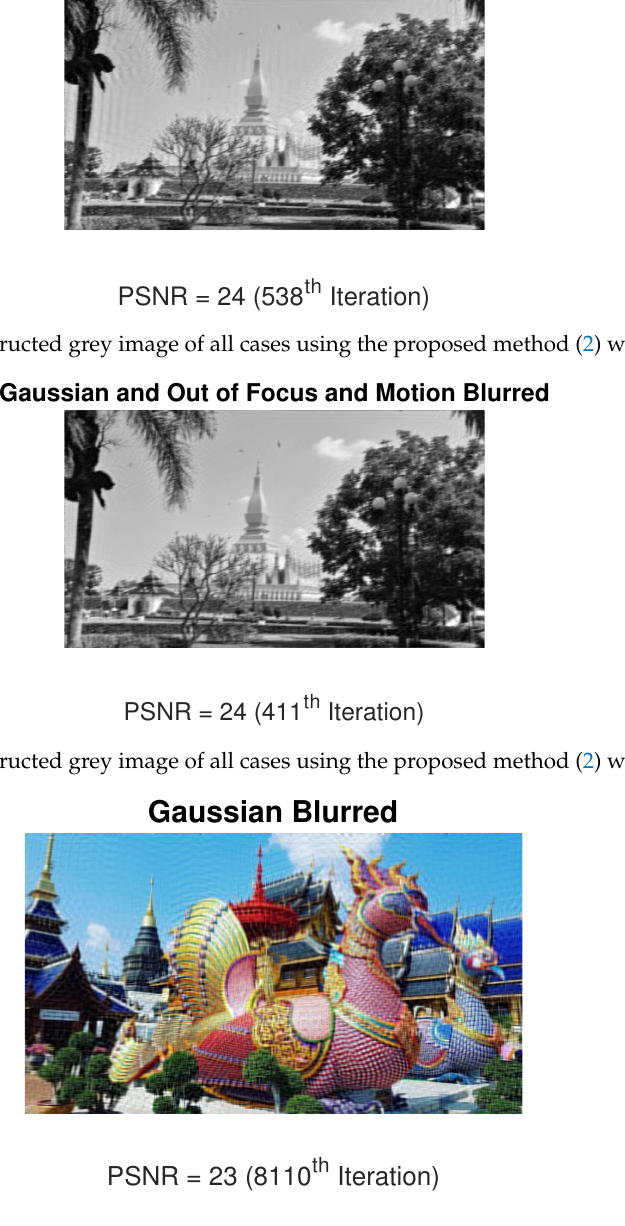
Figure 43. The reconstructed RGB image of all cases using the proposed method (2) with PSNR =